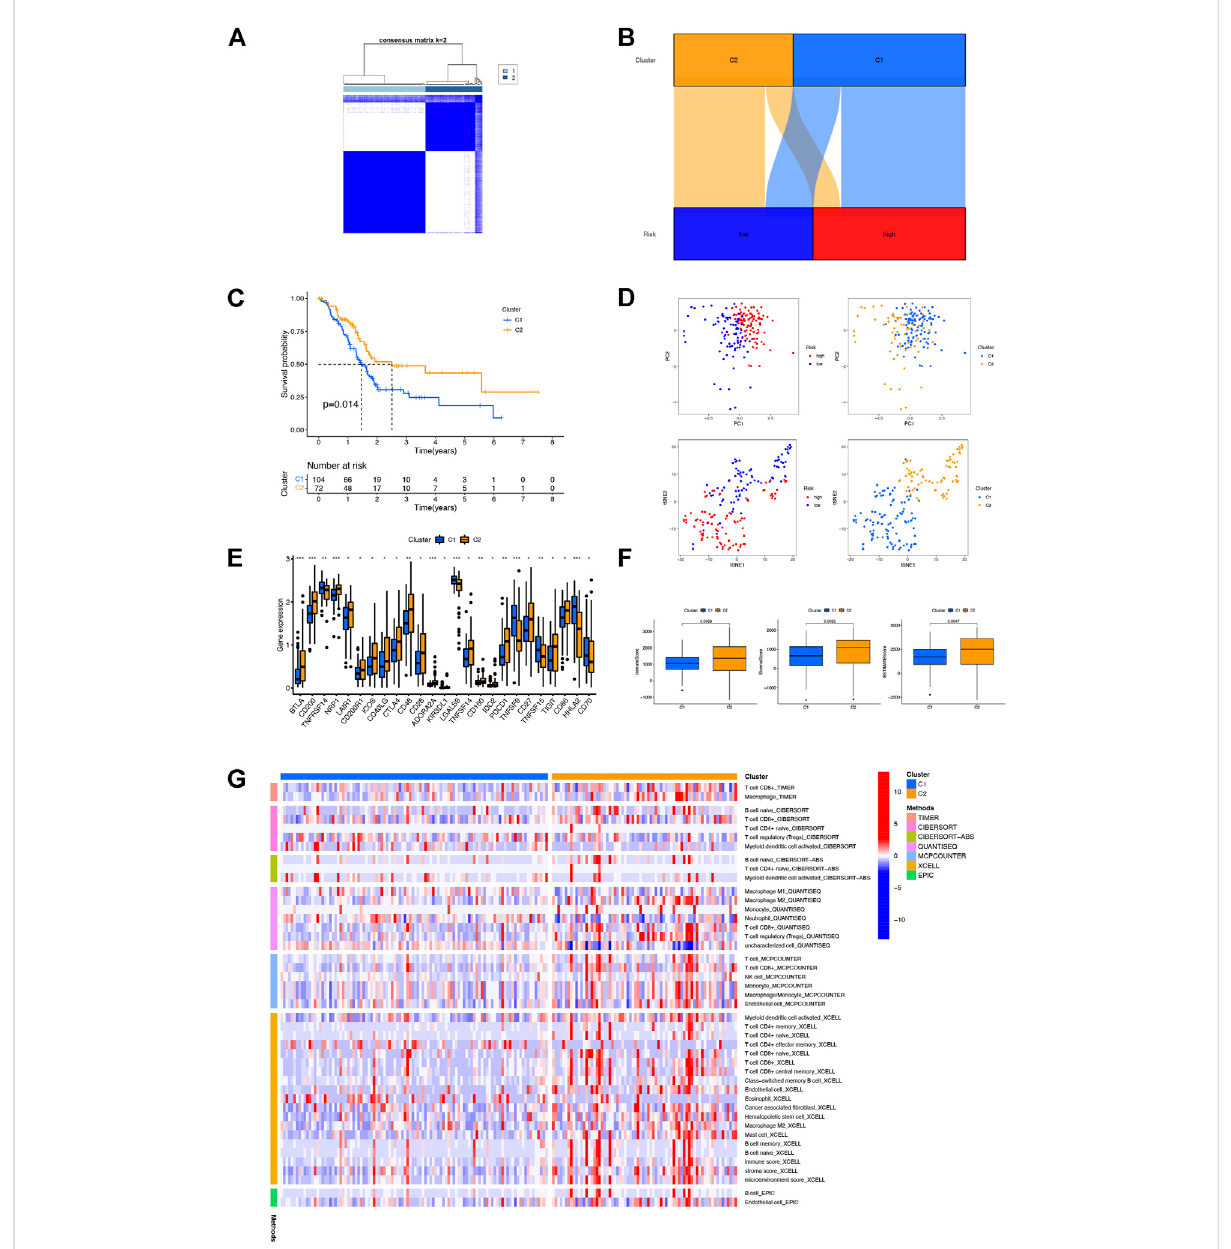
FIGURE 6 Distinction between different clusters. (A) Patients divided into two clusters by ConsensusClusterPlus. (B) Sankey diagram of different clusters and risk groups. (C) Kaplan – Meier survival curves of OS in clusters. (D) PCA and t-SNE of risk groups and clusters. (E) Differential expression of 25 checkpoint genes in different clusters. (F) Comparison of immune-related scores between clusters 1 and 2. (G) Heatmap of immune cells in